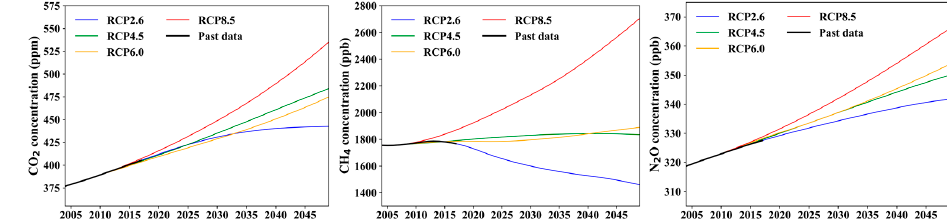
Figure 2. The concentrations of greenhouse gas under di ff erent climate scenarios from 2004 to 2049.